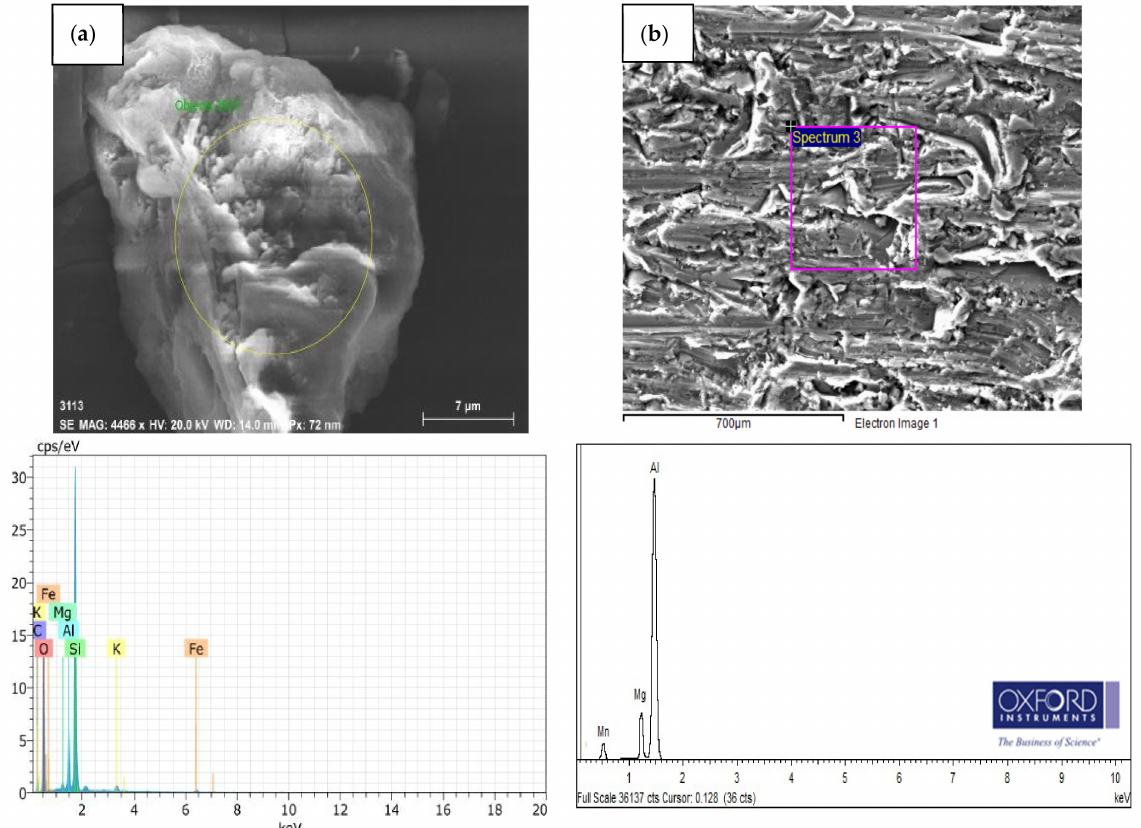
Figure 5. EDS analysis image: ( a ) aluminosilicate particle; ( b ) matrix material and its chemical